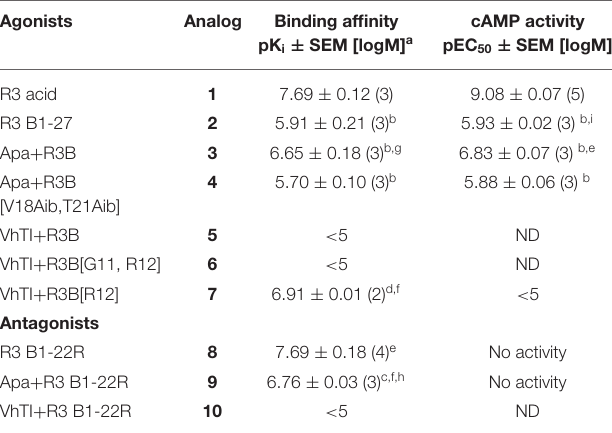
TABLE 2 | Binding affinities and cAMP activity of grafted